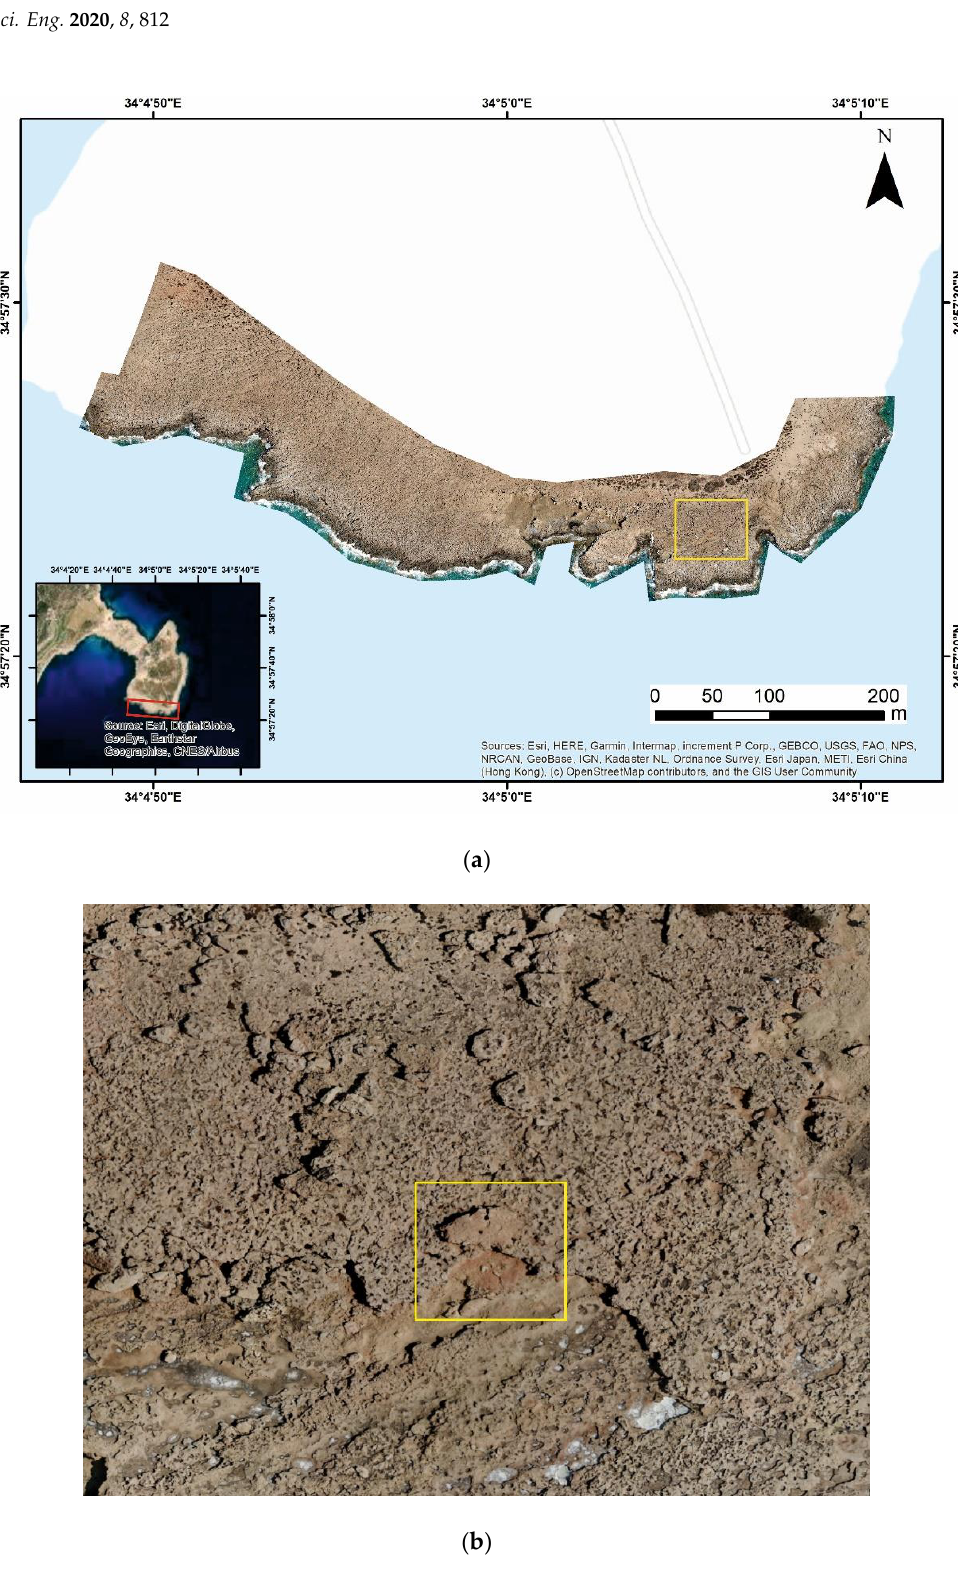
Figure 8. ( a ) Orthomosaic of the study area. Base map sources: Esri, DeLorme, HERE, TomTom, Intermap, increment P Corp., GEBCO, USGS, FAO, NPS, NRCAN, GeoBase, IGN, Kadaster NL, Ordnance Survey, Esri Japan, METI, Esri China (Hong Kong), swisstopo, MapmyIndia, and the GIS User Community; ( b ) a closer view (yellow box in ( a )) from the eastern part of the orthomosaic, where in the center (yellow square) a boulder (no 189) is evident that has been turned upside down, and its original location is clearly visible, supporting a joint-bounded scenario.